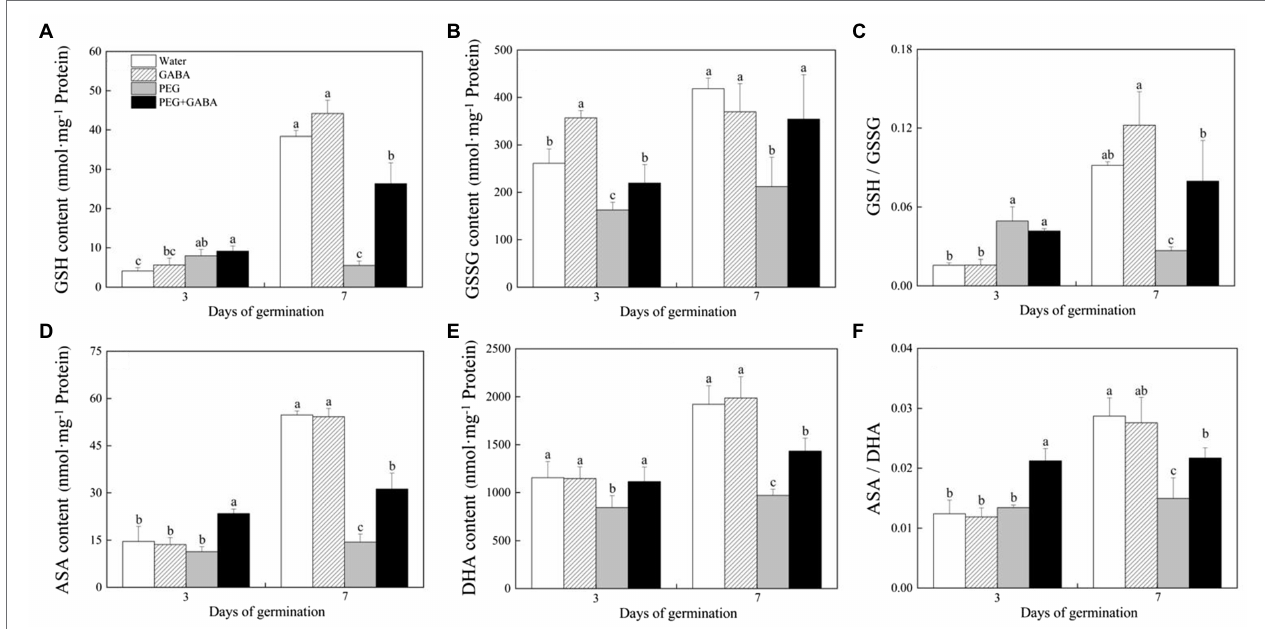
FIGURE 6 | Effects of seed priming with deionized water or γ -aminobutyric acid (GABA) on content of non-enzymatic antioxidants glutathione (GSH; A ), reduced glutathione (GSSG; B ), the GSH/GSSG ratio (C) , ascorbic acid (AsA; D ), dehydroascorbic acid (DHA; E ), and the ASA/DHA ratio (F) during the germination of white clover seeds under water